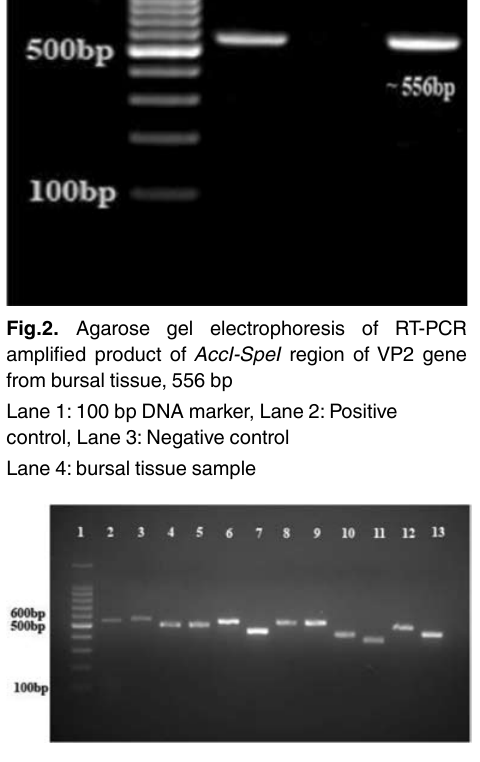
638 Sequence analysis of VP1, VP2 and VP3 genes of an IBDV from a field outbreak in Kerala